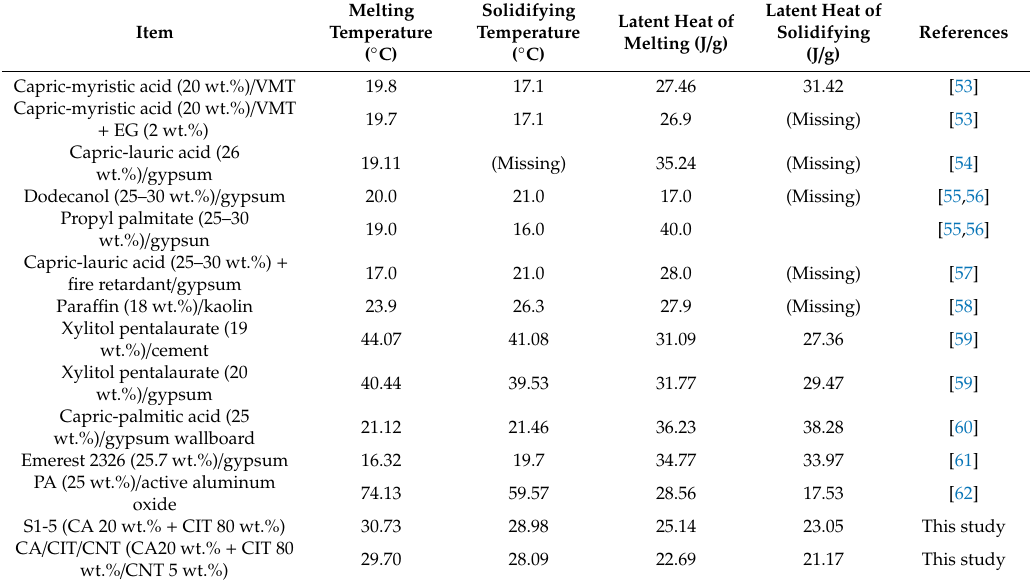
Figure 9. DSC curves of CA, CA / CIT form-stable phase change material (FSPCM), and CA / CIT / CNT FSPCM. Table 4. Thermal properties and results comparison with some literatures.